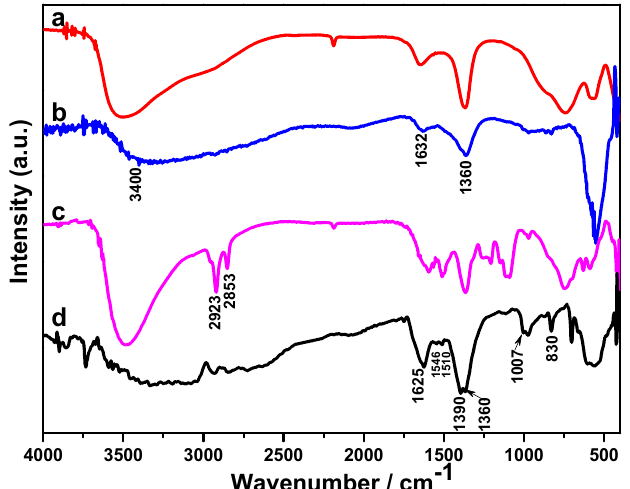
Figure 9. FT-IR spectra of (a) CoAl LDH obtained by pristine sample, (b) CoAl LDH obtained by 6000 GCD cycles, (c) CoAl LDH-PANI obtained by pristine sample, and (d) CoAl LDH-PANI obtained by 6000 GCD cycles.